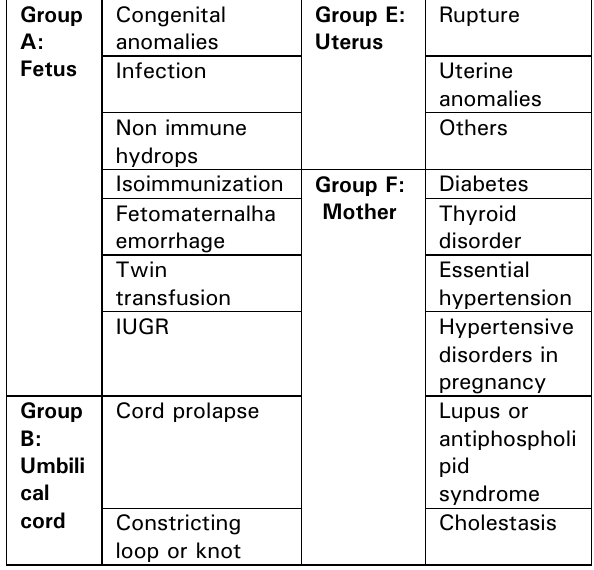
Table 1: ReCoDe Classification System